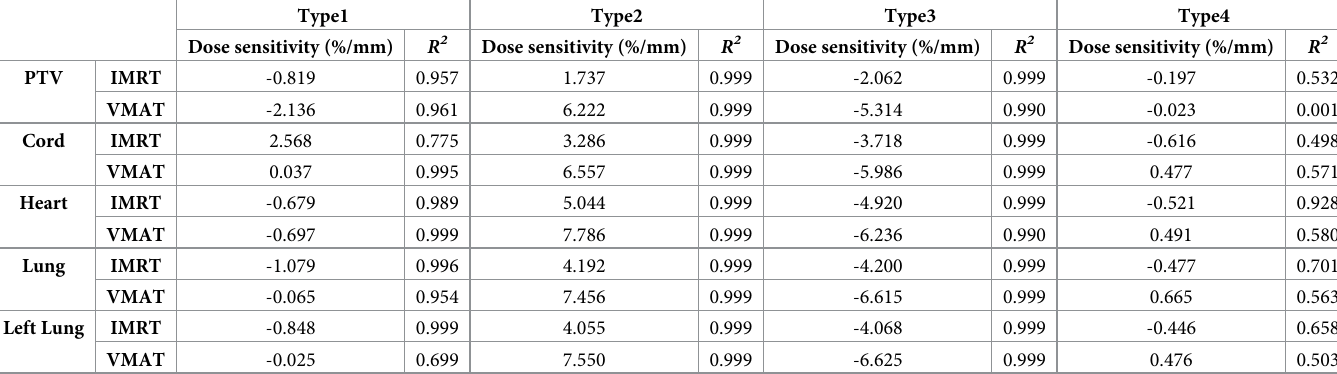
Table 5. Dose sensitivity analysis of MLC error to PTV and OAR in IMRT and VMAT plans.